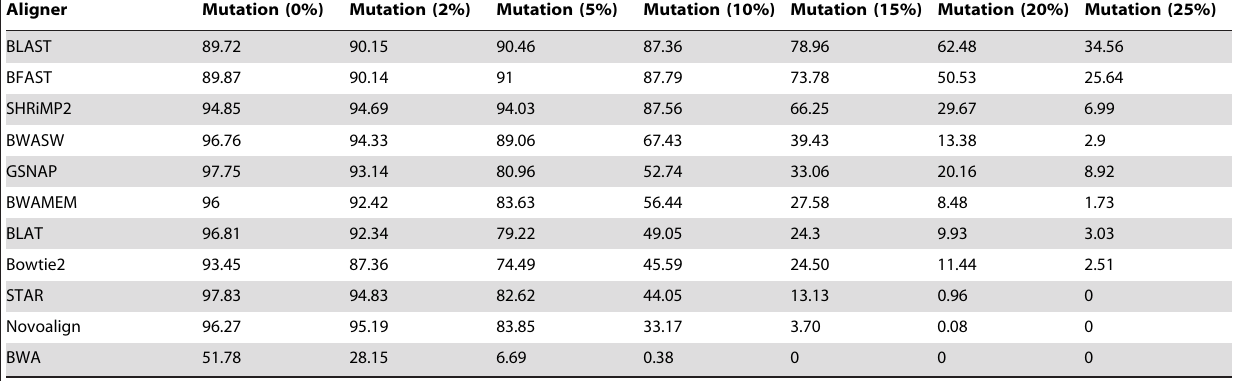
Table 4. Summary of values for the FS measure.